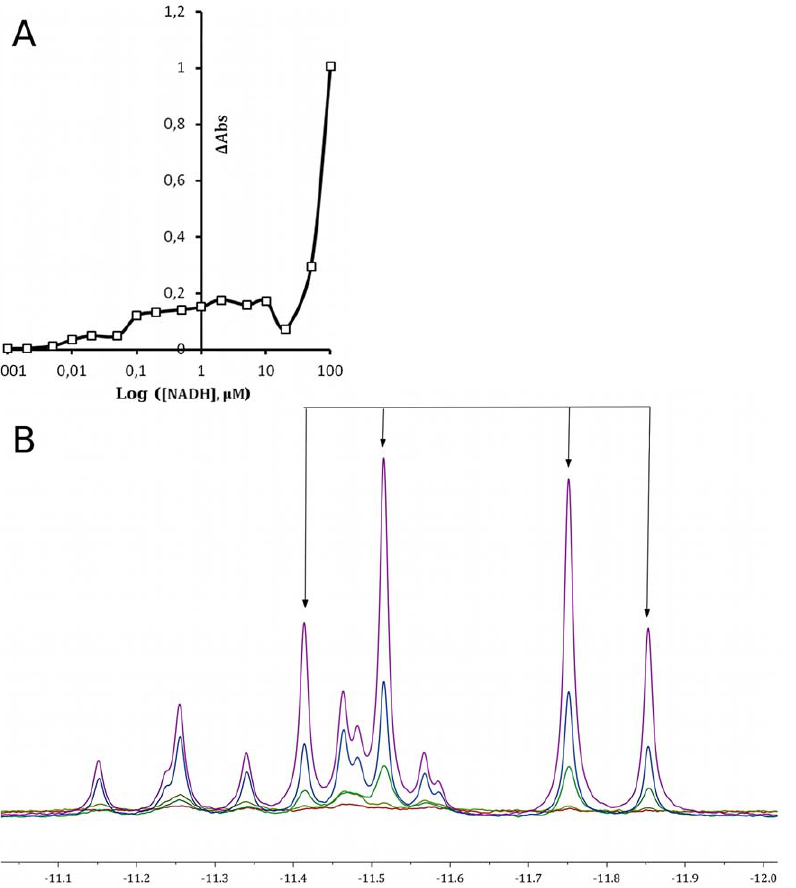
Figure 4. Substrate affinity. A. NADH binding to 50 m M apoWrbA determined by UV spectroscopy. Difference absorbance at 265 nm (see text) is plotted vs. [NADH]. The solid line is intended only to guide the eye and does not represent a fit to the data. B. NAD binding to 200 m M apoWrbA detected by 31 P NMR. Spectra at 100, 200, 500, 1000 and 2000 m M NAD from bottom to top, respectively, are overlaid. The bracket with four arrows indicates the doublet pair characteristic of free